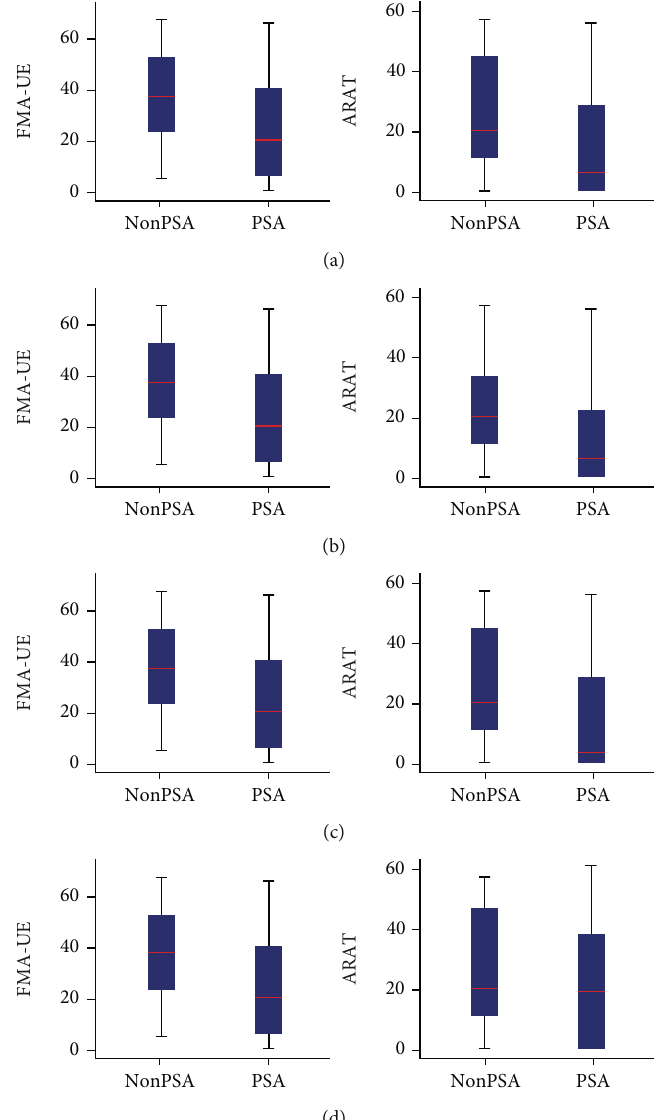
Figure 2: Clinical measurement of the FMA-UE and ARAT scores. (a) Comparison of the FMA-UE and ARAT total scores between the non-PSA and PSA groups. (b – d) Comparisons of the FMA-UE and ARAT total scores between the non-PSA and PSA groups in 1-3 months, 4-6 months, and > 6 months. Signi fi cant di ff erences were observed in both groups. p < 0 : 001 . Abbreviation: non-PSA indicates patients without poststroke aphasia; PSA indicates patients with poststroke aphasia; FMA-UE indicates the Fugl-Meyer assessment for the upper extremity; ARAT indicates the action research and action